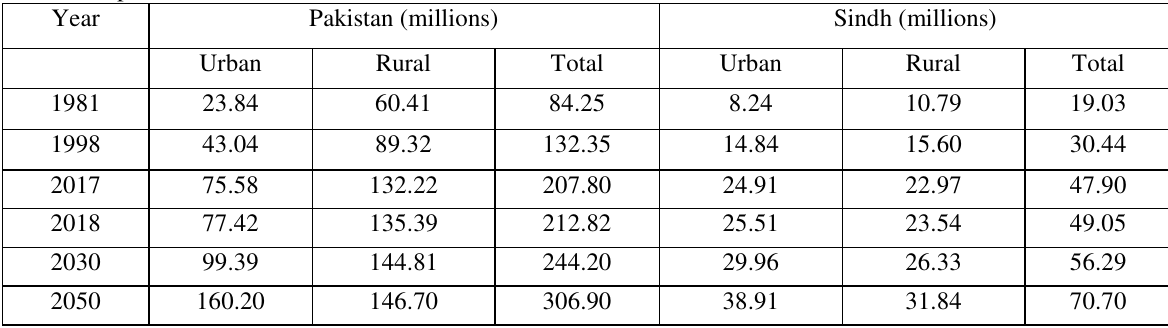
Table 2: Municipal Water Demand in Pakistan and Sindh Annual Water demand (MAF) under each scenario Pakistan Without climate change Climate scenario with 1